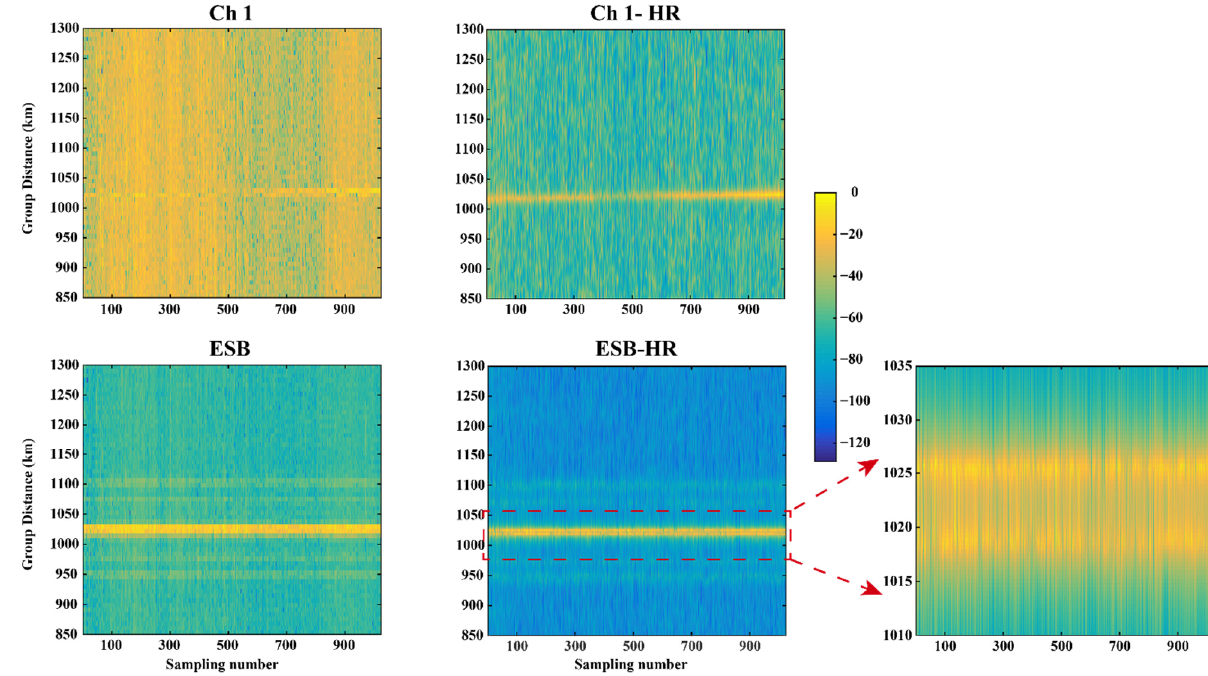
Figure 12. The OIS ionogram of 11.05 MHz under different conditions.